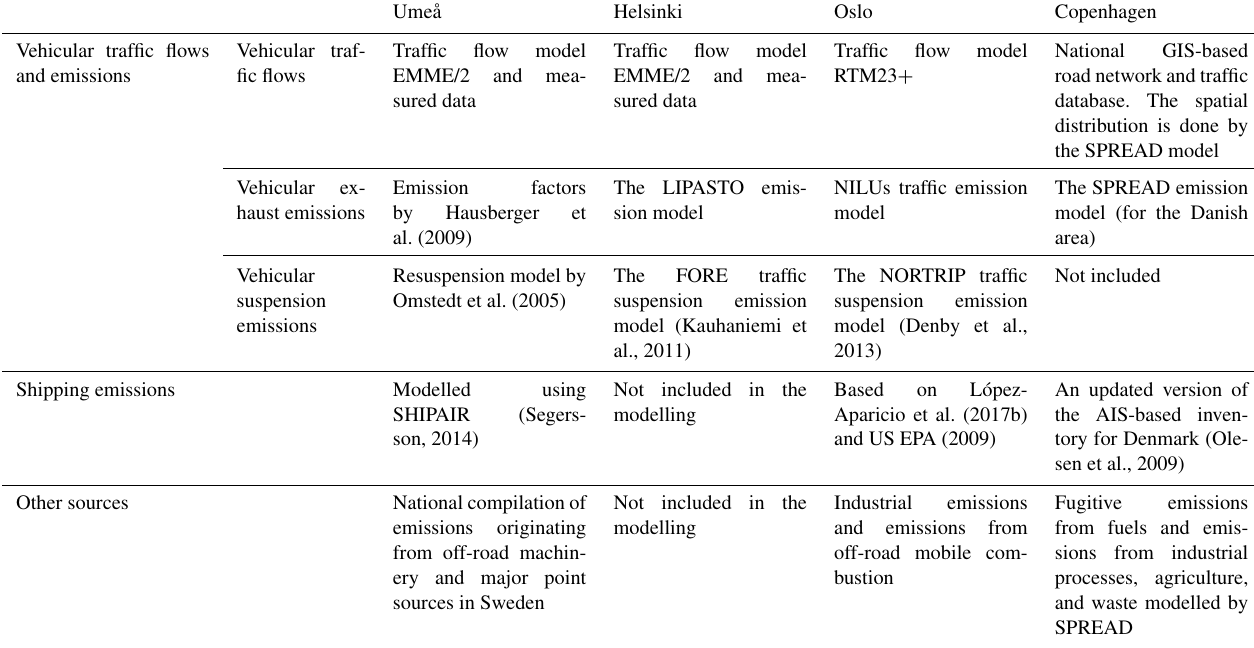
Table 2. Assessment of the traffic flows and emissions from vehicular traffic and other source categories (except for RWC) in the target